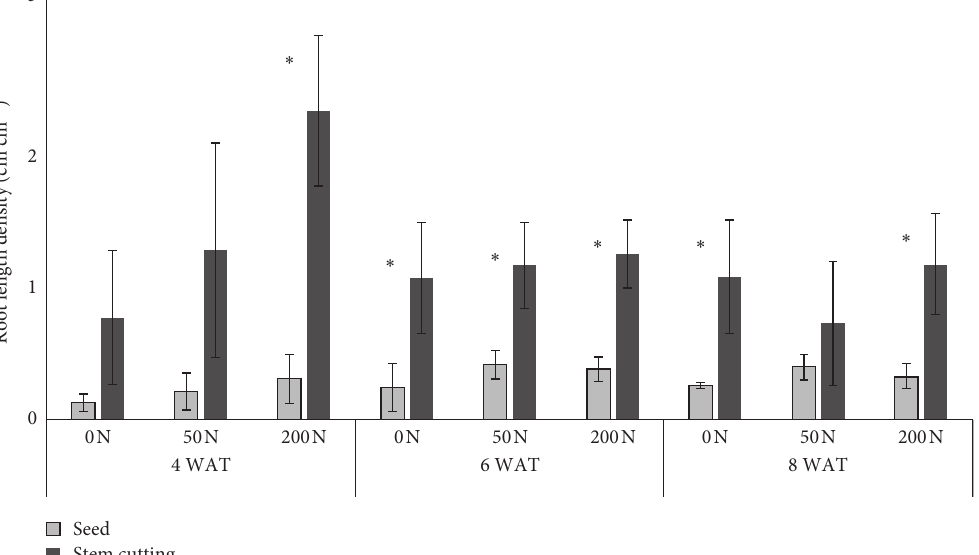
Figure 8: Root length density (cm cm − 3 ) of E. pellita seedlings from seeds and stem cutting plant material at different nitrogen concentrations (0, 50, and 200 kg N ha − 1 ) at three selected dates of root measurement” 4 weeks after transplanting, WAT, 6 WAT, and 8 WAT. The mean values were tested using independent samples t -test between seed and stem cutting propagation for each fertilizer treatment and date. All mean values were significantly different ∗ ( P < 0 . 05). Error bars denote standard deviations of the mean ( n �